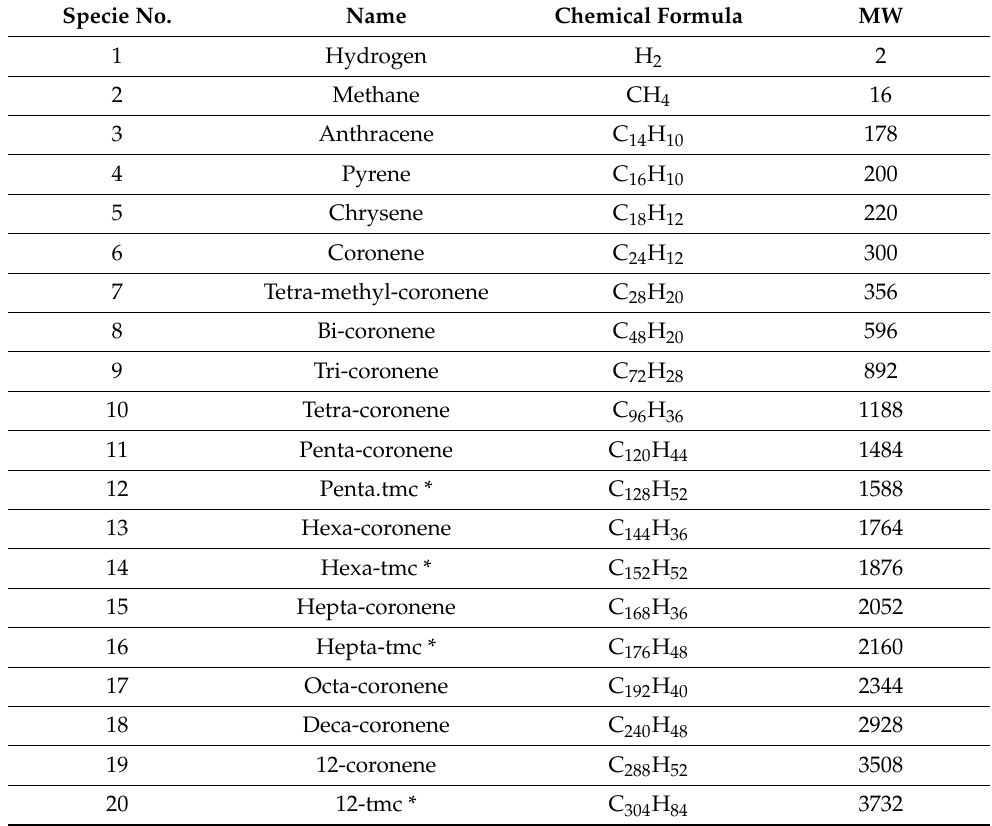
Table 1. Selected set of representative PAH compounds in the present work. Specie